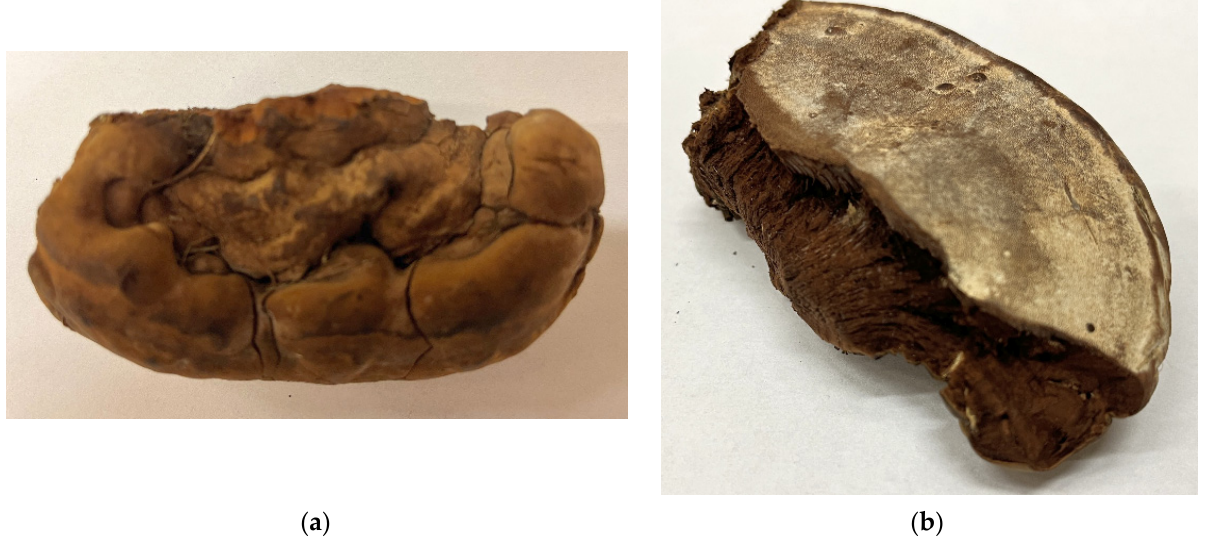
Figure 1. Part of basidiocarp of G. resinaceum used in this work: ( a ) top view; ( b ) bottom view.